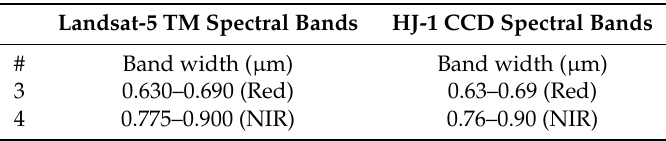
Table 3. Red and NIR bands of Landsat-5 TM and HJ-1